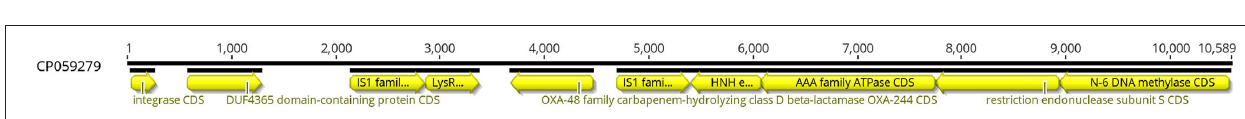
phenotypes were observed particularly near sewage